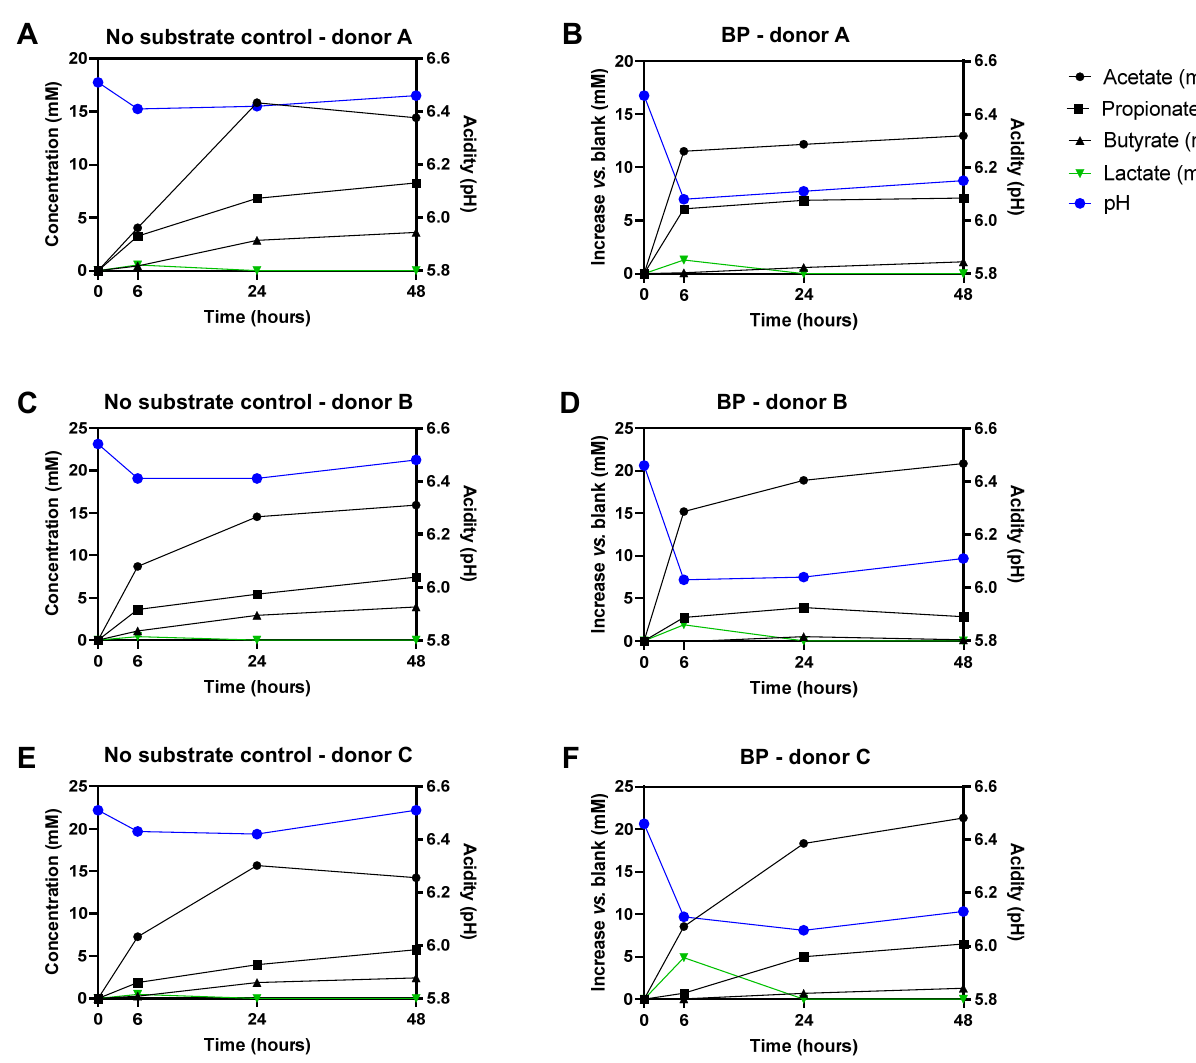
Figure 4. Temporal changes in microbial metabolic activity markers (acetate, propionate, butyrate, lactate, and pH) for three different healthy adult donors (donor A, donor B, donor C) during 48 h fecal batch incubations for the ‘no substrate control’ (black) and upon treatment with baobab fruit pulp powder (right) ( A – F ). Temporal profiles of reference conditions indicate absolute values while profiles of treatments with baobab fruit pulp powder represent changes as compared to the reference conditions.